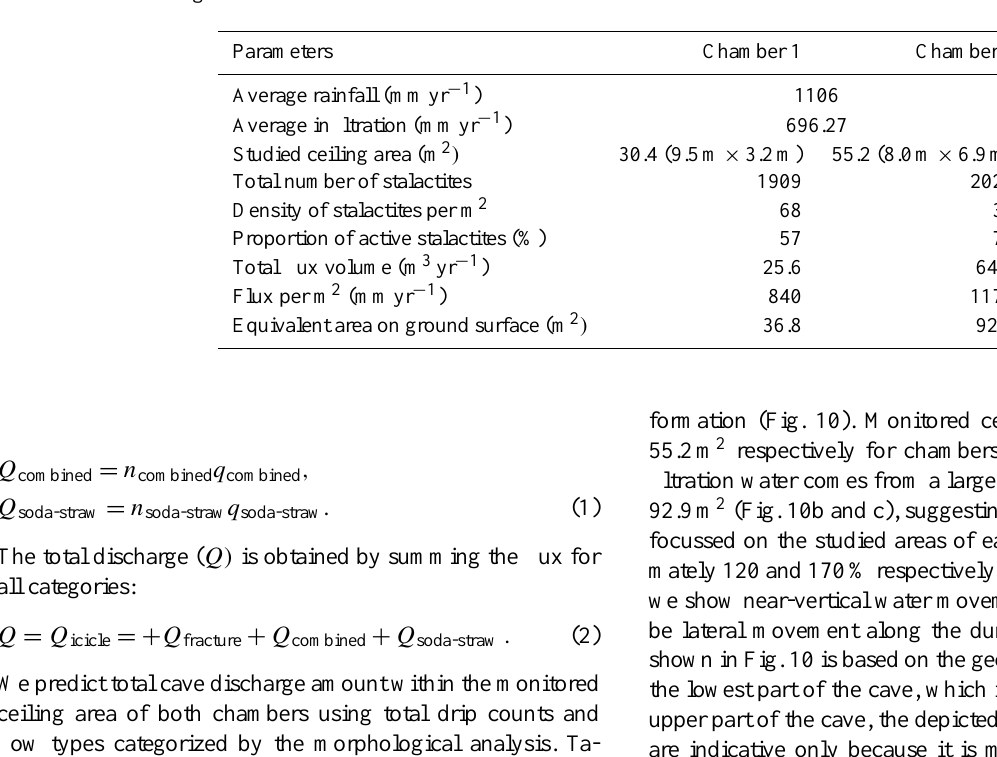
Figure 9. Correlation matrix for various drip sites with flow type classification for (a) chamber 1 and (b) chamber 2. Different flow types (I: icicle; F: fracture; C: combined; S: soda straw) characterized by the morphological analysis are shown in parentheses (left y axes and x axes). Limestone thicknesses over the drip sites are on the right y axes. The colour scale indicates the correlation coefficient between drip time series. Table 3. Cave discharge calculation for both